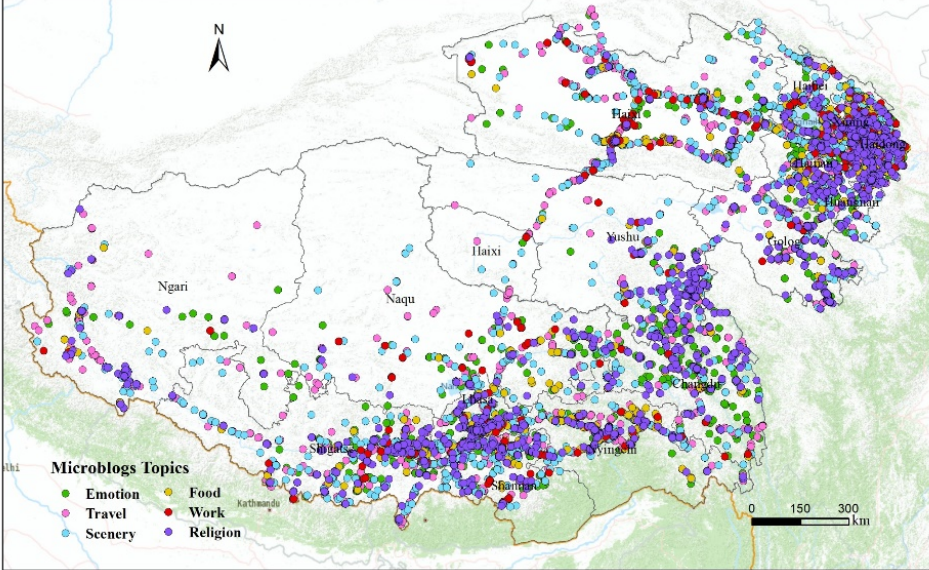
Figure 4. Spatial distribution of topics extracted from resident microblogs.